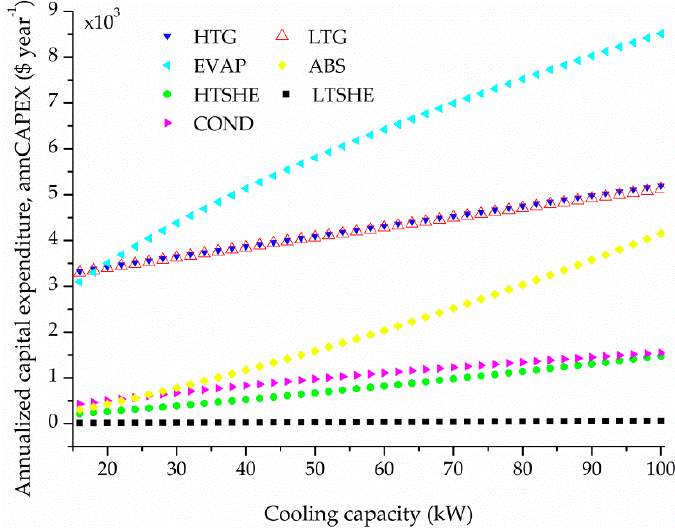
Figure 9. ( a ) Optimal cost values for steam requirements; ( b ) Optimal cost values for cooling water requirements, as a function of the cooling capacity level.